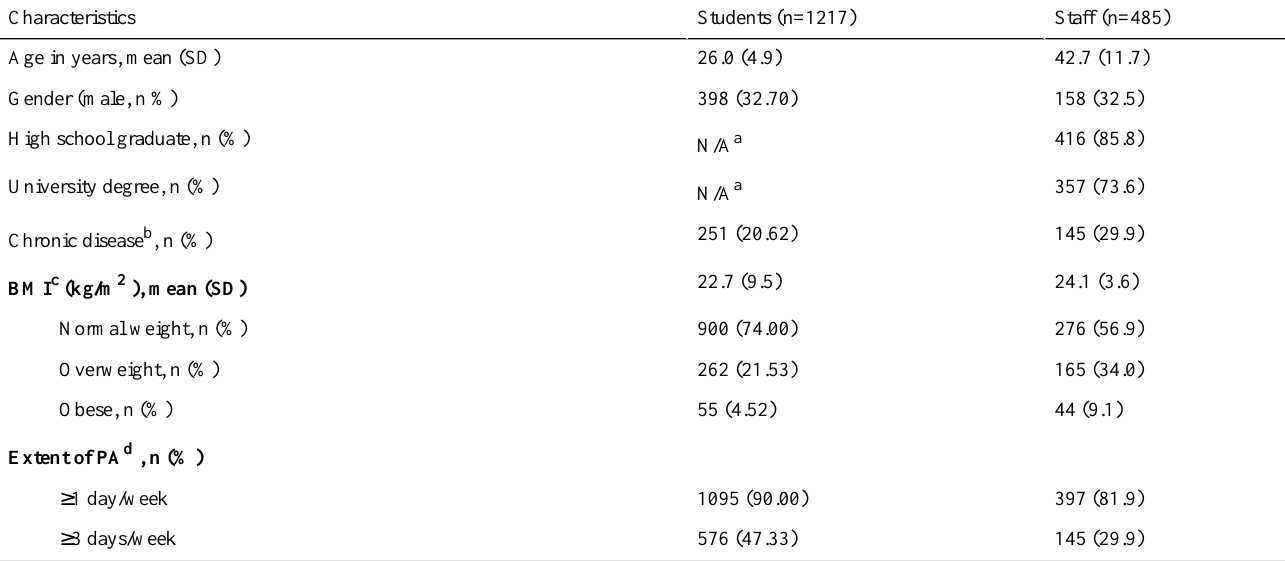
Table 1. Basic characteristics of study